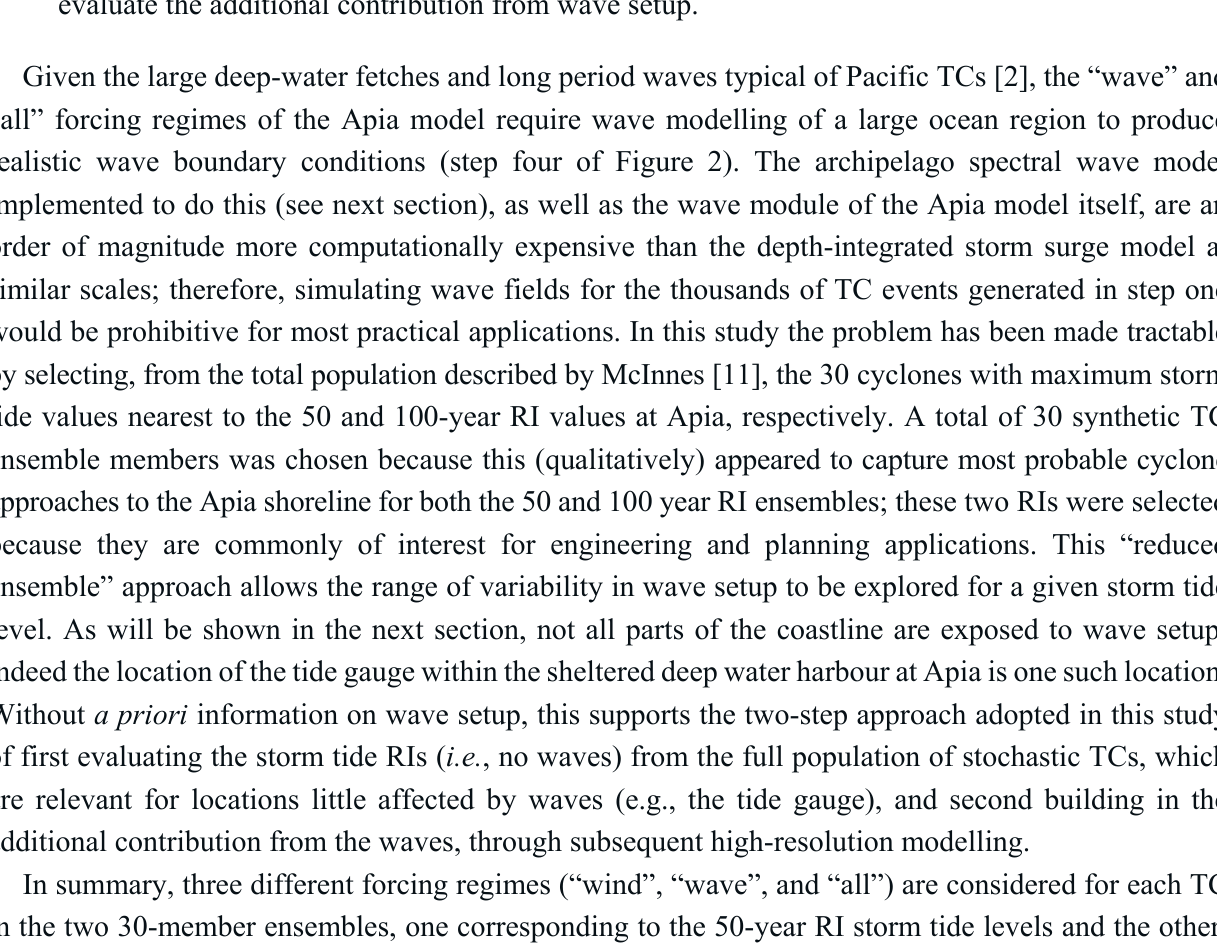
Figure 2. Schematic illustrates the method adopted in this study. Steps 1 to 3 relate to the study of McInnes et al . [11] in which synthetic cyclone and hydrodynamic models are used to estimate storm tide return periods. Steps four and five are undertaken in this study to evaluate the additional contribution from wave